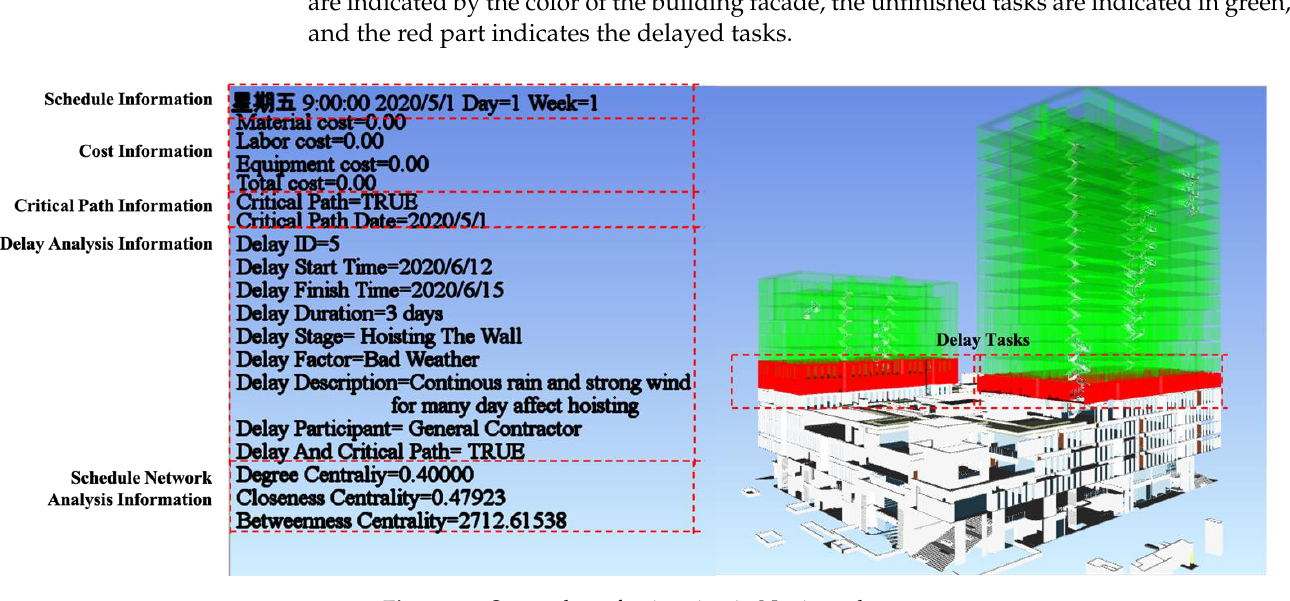
Figure 14. Screenshot of animation in Navisworks.